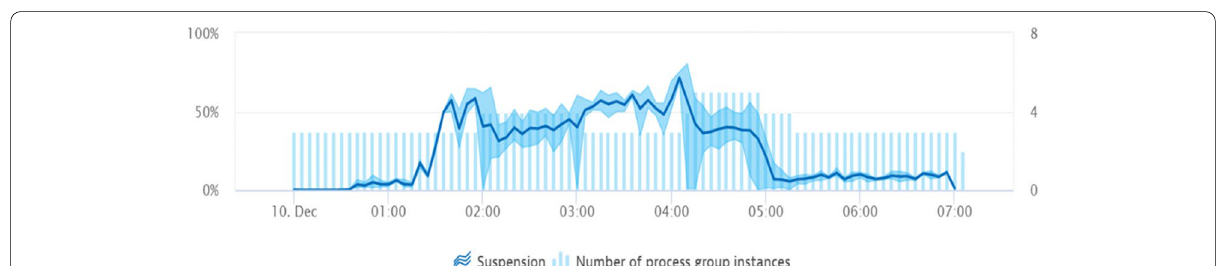
Fig. 27 Suspension % vs. the number of monolith frontend